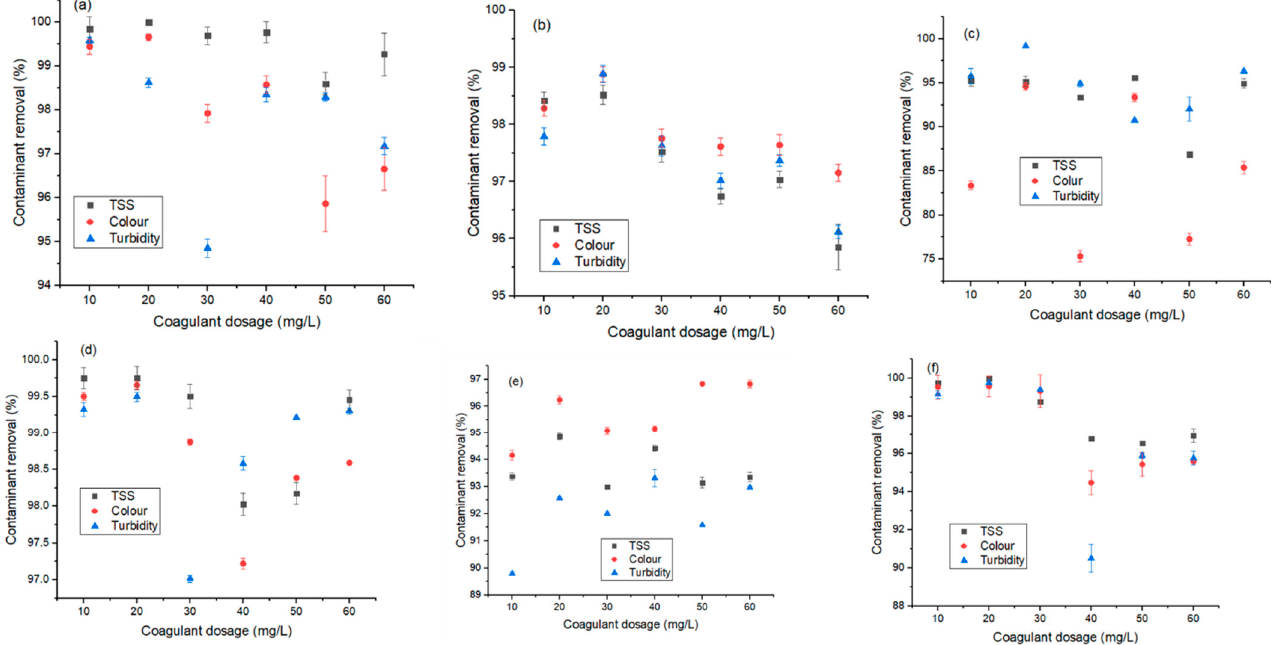
Figure 3. Effect of coagulant dosage (mg/L) on contaminant removal (TSS (black), color (red), and turbidity (blue)) using ( a ) A: alum, ( b ) E: eggshells, ( c ) F: ferromagnetite, ( d ) FE, ( e ) FA, and ( f ) FEA. TSS: total suspended solids.